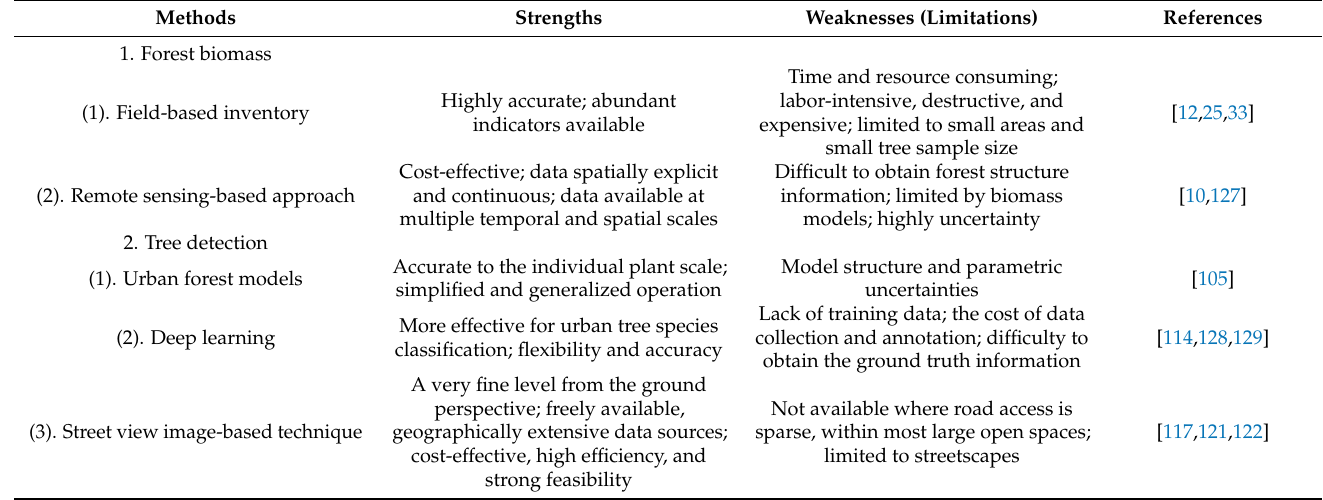
Table 1. Strengths and weaknesses of forest biomass estimation and tree detection